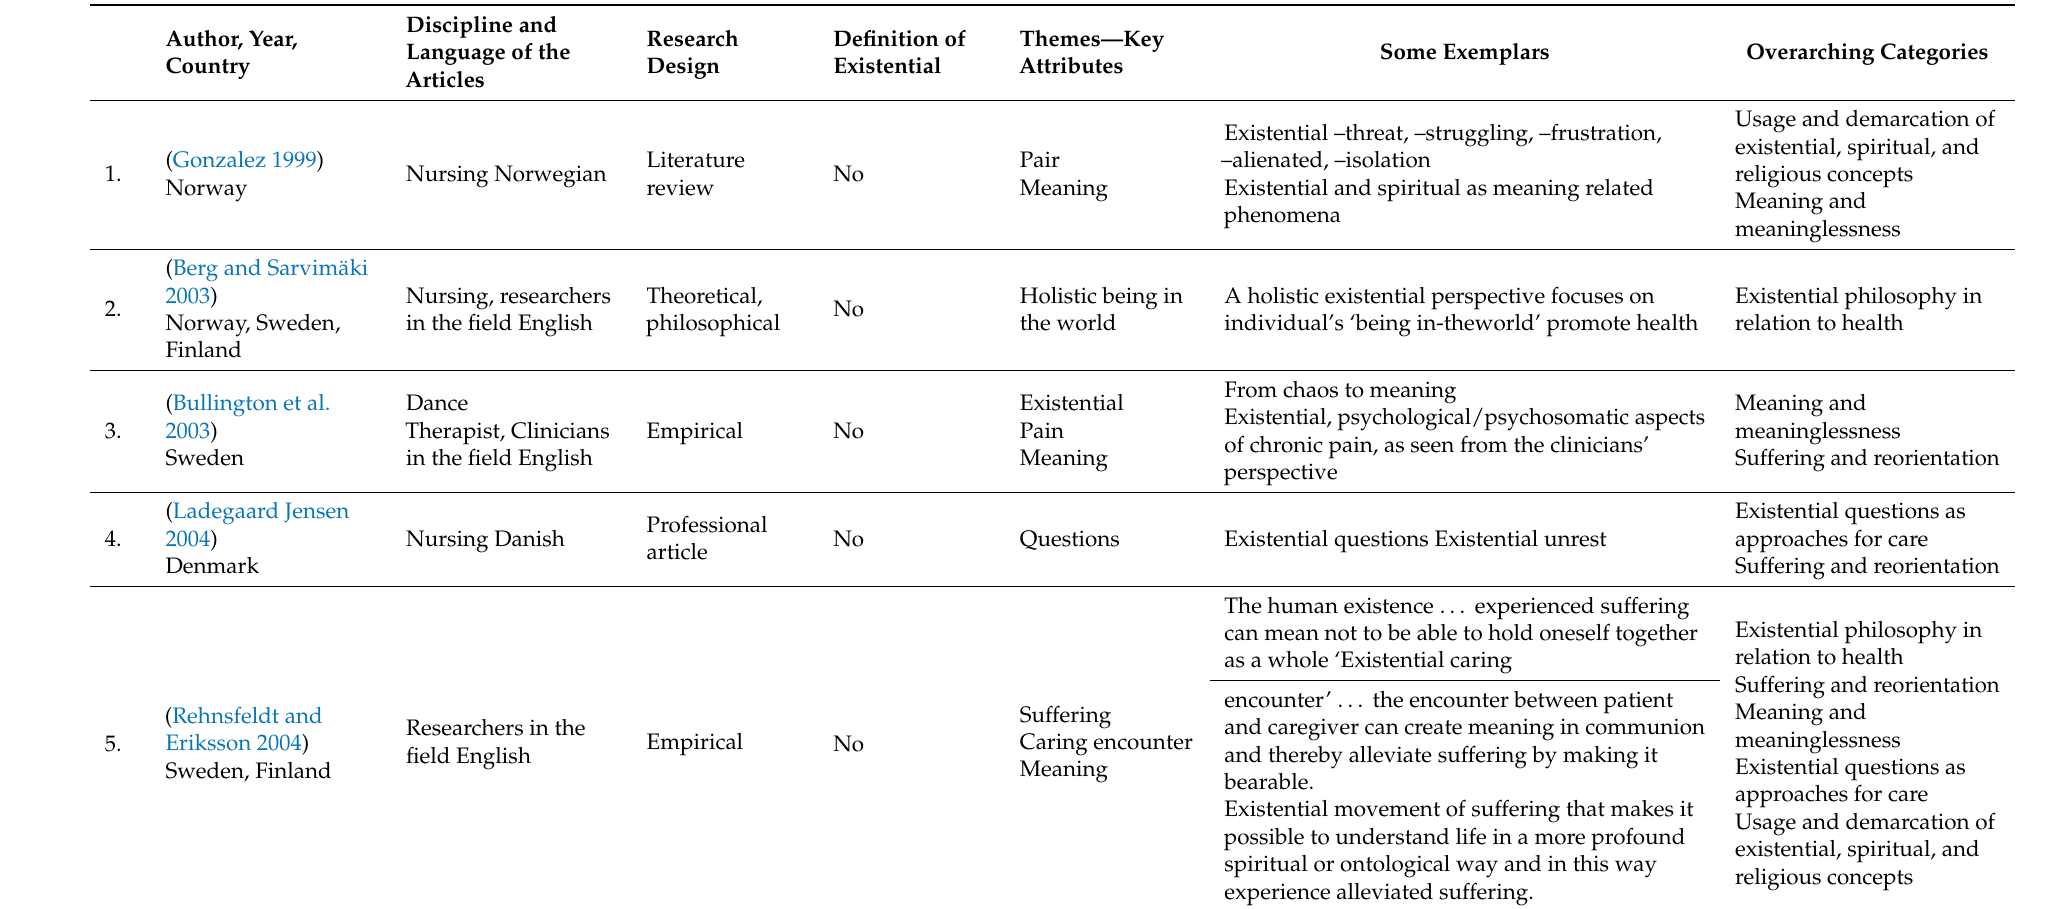
Table A1. Overview table of all articles and analytical overarching